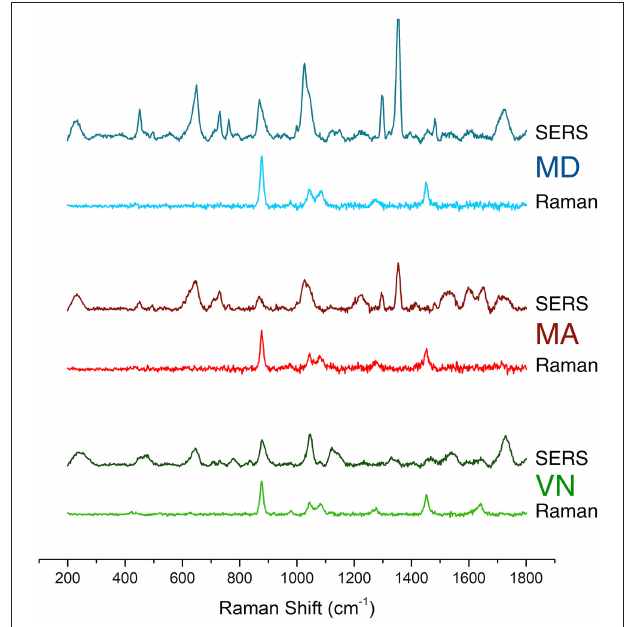
FIGURE 3 | Normal Raman and SERS spectra for the three white wine samples of the Maduro (MD and MA) and Verde (VA) varieties, acquired using a 532nm laser line. Spectra were baseline corrected using a polynomial subtraction procedure. Original spectra are in Supplementary Figure 3